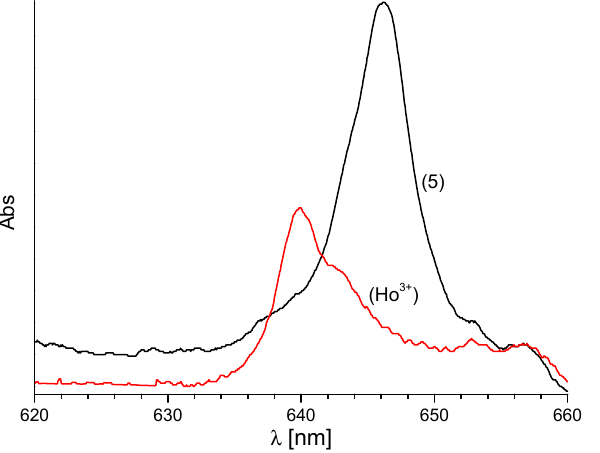
Figure 6. The absorption spectra of Ho 3+ ion in acetonitrile solution in Ho(OTf) 3 and (Ho) 5 in range 5 I 8 - 5 F 5 transitions, c = 2·× 10 − 3 M.